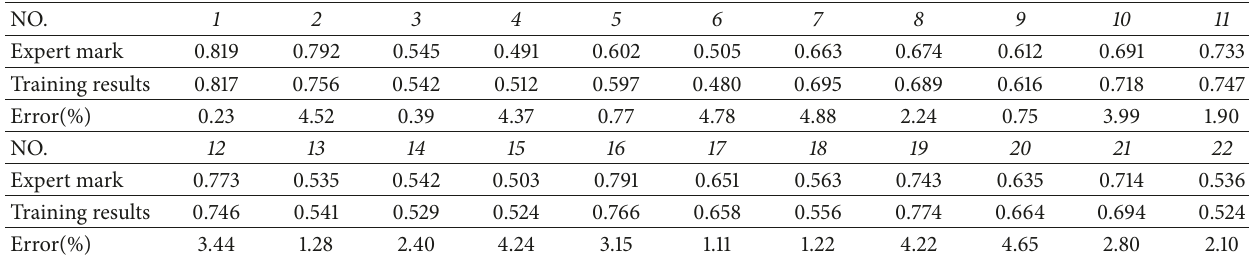
Table 5: BP neural network results of training on railway construction risks in 22 Asian countries.